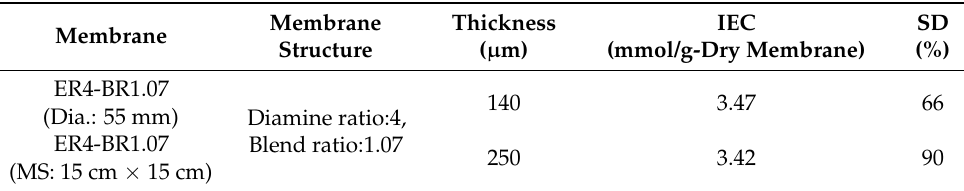
Table 6. The properties of small- and large-scale membranes.